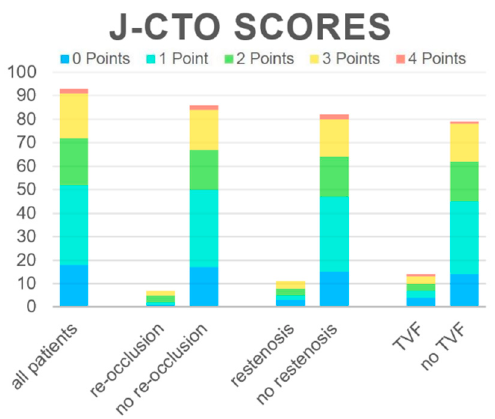
Figure 1. Distribution of the J-CTO score in all patients in the groups reaching endpoints. J-CTO scores were calculated for the whole study group and stratified for all single endpoints and the combined endpoint. In our study, the distribution of J-CTO scores did not differ significantly between groups (for details, see the text).